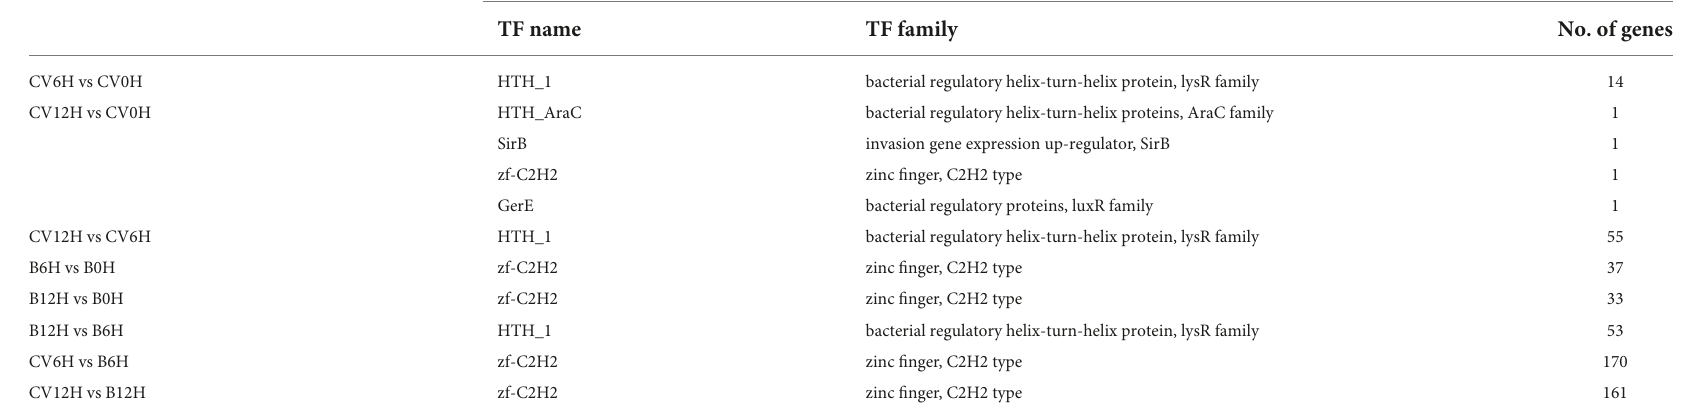
TABLE 3 The most abundantly detected TFs among VF whiteflies in response to CLCuMuV infection. Comparative group